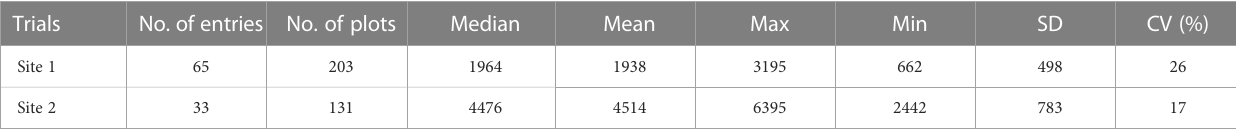
TABLE 1 Summary statistics of fi eld pea seed yield (kg/ha) from two locations. Trials